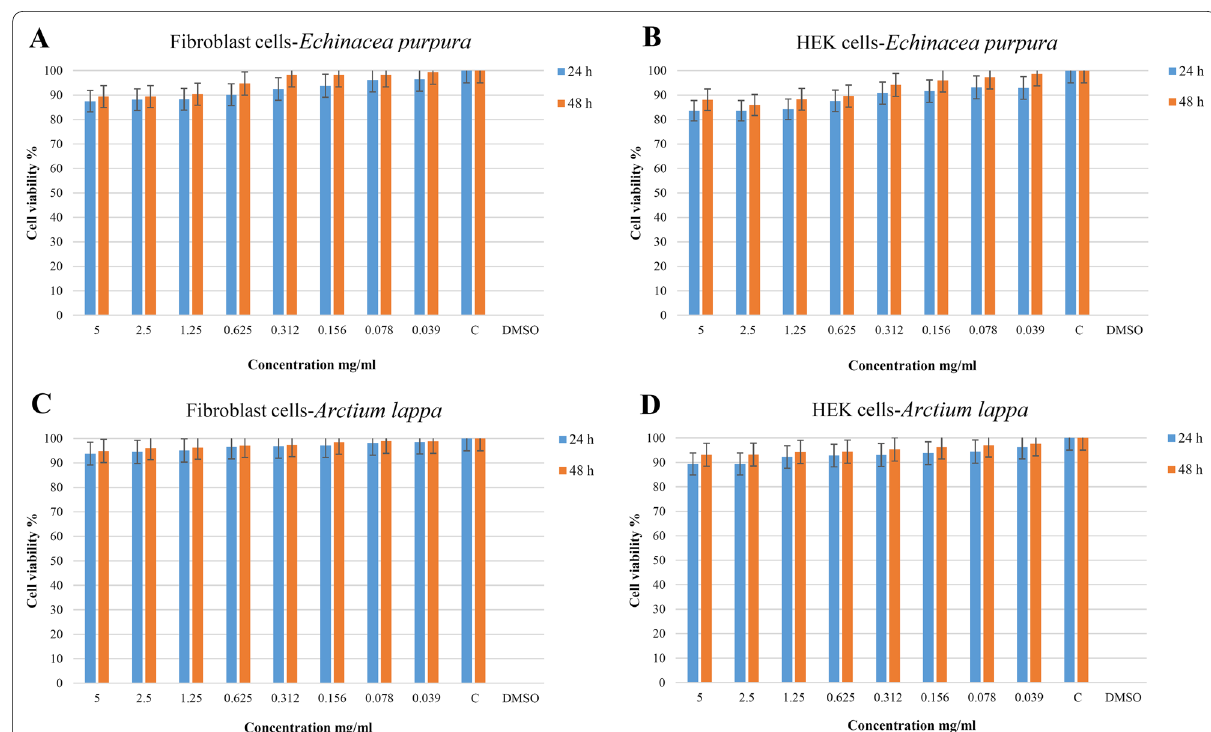
Fig. 3 Cell viability after treatment with Echinacea and Arctium extracts and the formulation after 24 and 48 h. A The HDFa cells viability of Echinacea purpurea : There were no significant differences with the control group for 0.312 mg/ml concentrations and lower after 24 h ( p > 0.05). This threshold for an incubation time of 48 h would be 0.625 mg/ml. B The HEK cells viability of Echinacea purpurea : There were no significant differences with the control group for the concentrations of 0.625 mg/ml and lower after 24 h ( p > 0.05). This threshold for an incubation time of 48 h would be 0.156 mg/ml. C The HDFa cells viability of Arctium lappa : There were no significant differences with the control group for 1.25 mg/ml and lower after 24 h ( p > 0.05). This threshold for an incubation time of 48 h would be 2.5 mg/ml. D The HEK cells viability of Arctium lappa : There were no significant differences with the control group for all tested concentrations after 24 or 48 h ( p >